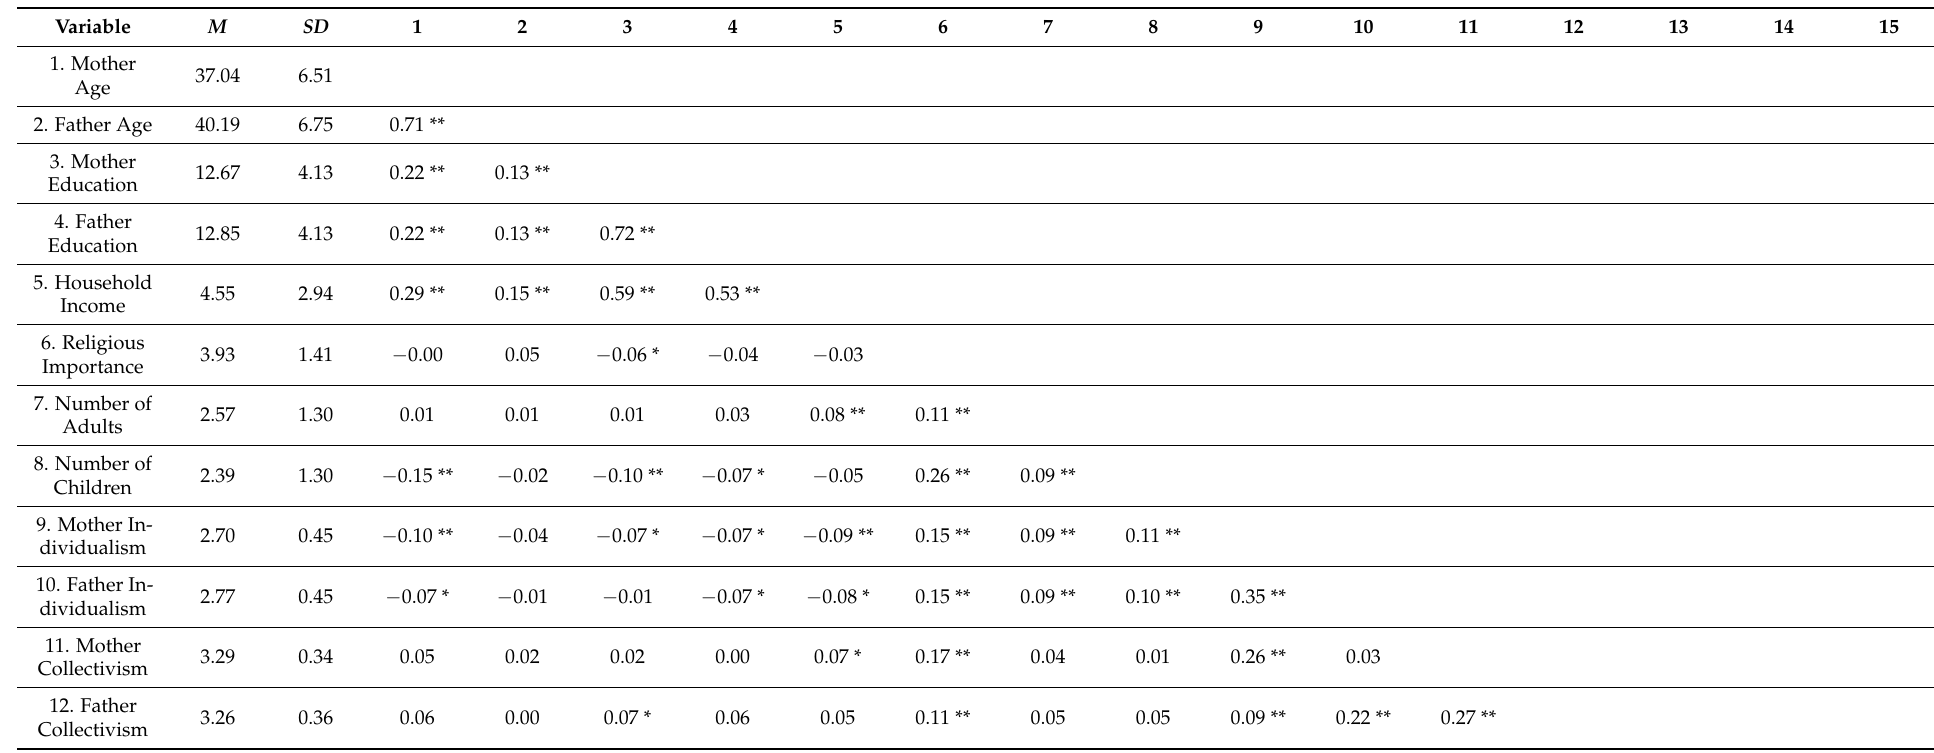
Table 2. Means, standard deviations, and correlations for the entire